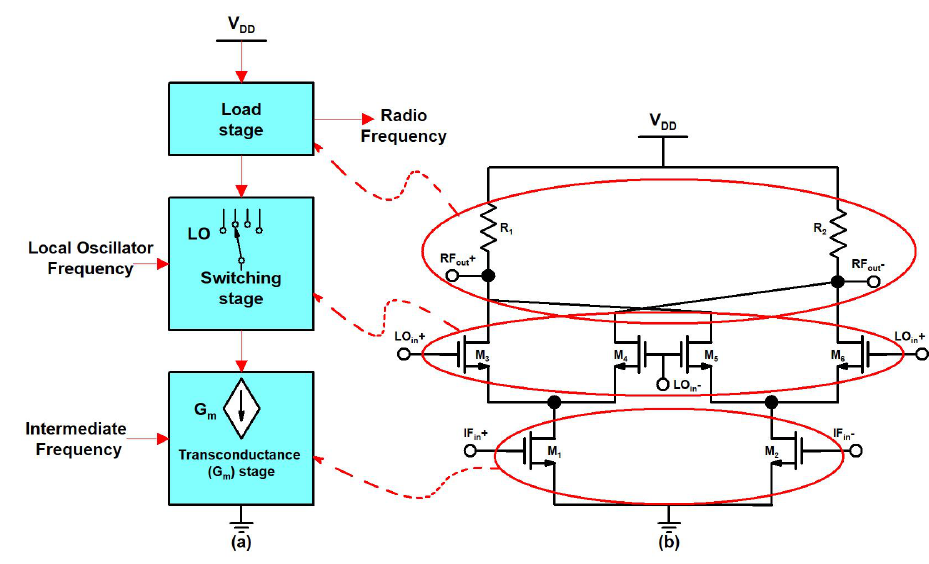
Figure 2. ( a ) Block diagram, ( b ) schematic of the conventional of